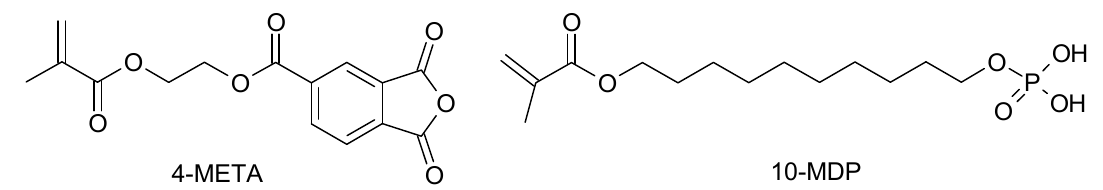
Figure 1. Monomers used as bonding agents in resin cements.